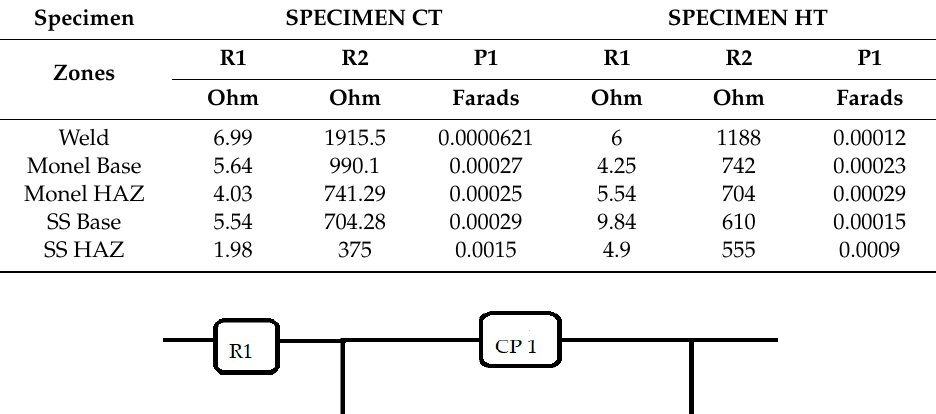
Figure 17. Phase angle variation for HT specimen. Table 3. Polarization parameters of Monel 400 and SS 316L for specimen’s CT and HT.